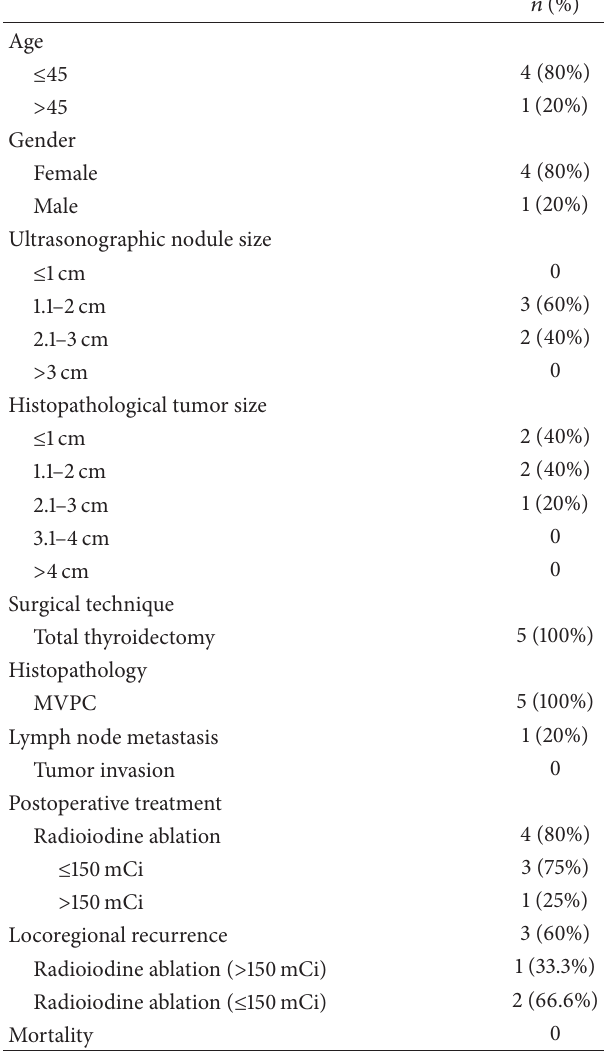
Table 1: General characteristics of